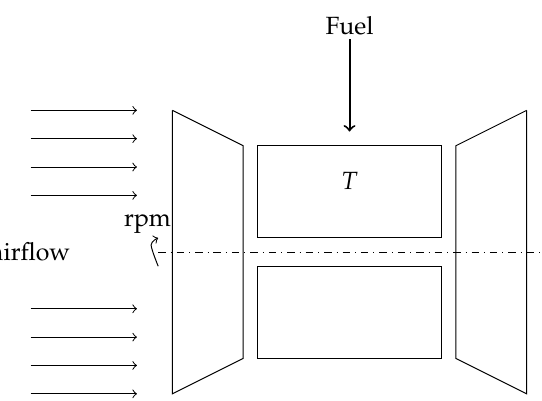
Figure 2. Simplified schematics of turbine—parts important for current investigations.